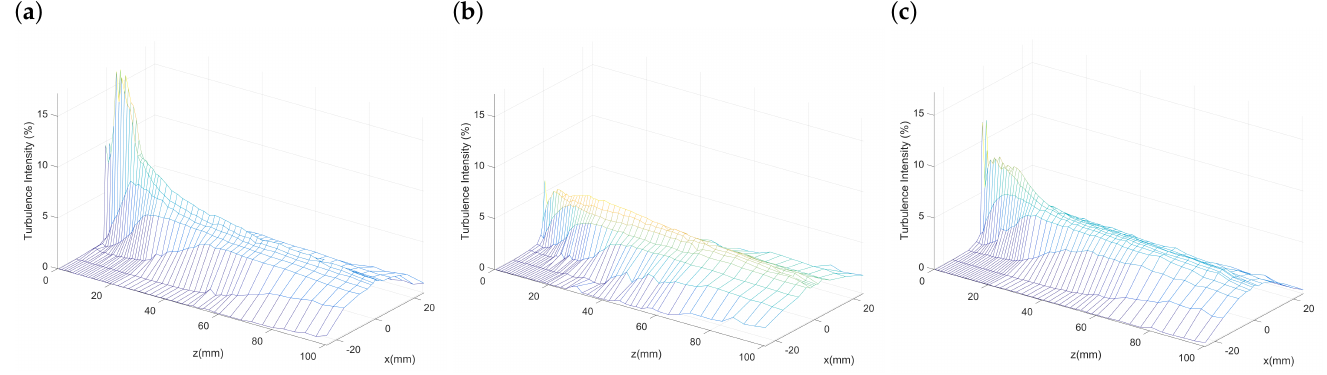
Figure 5. Mesh plots of turbulence intensity: ( a ) Original nozzle, ( b ) nozzle with outer-director, and ( c ) nozzle with